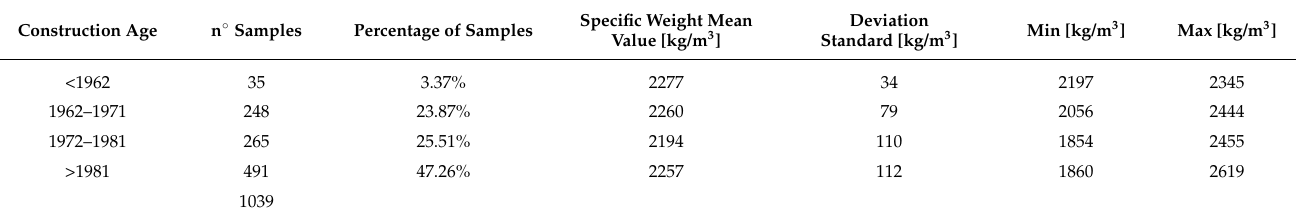
Table 2. DB_2: composition and main statistical